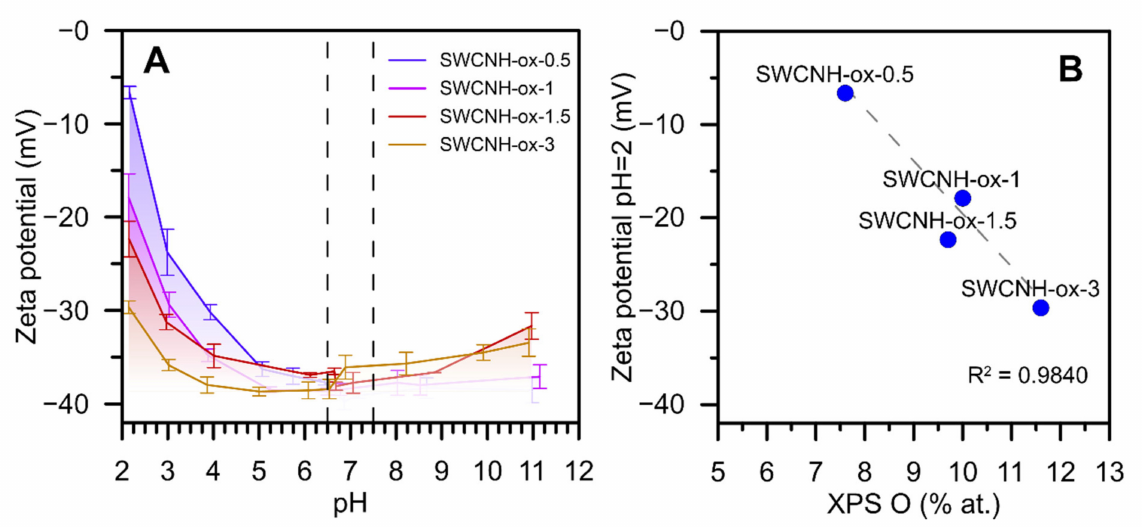
Figure 2. The results of ζ -potential analysis as a pH function at 25 ◦ C ( A ). Figure ( B ) shows the correlation between ζ -potential at pH = 2 and XPS-determined oxygen content. Determination coefficient was calculated for three samples (single-walled carbon nanohorn (SWCNH)-ox-0.5; 1;